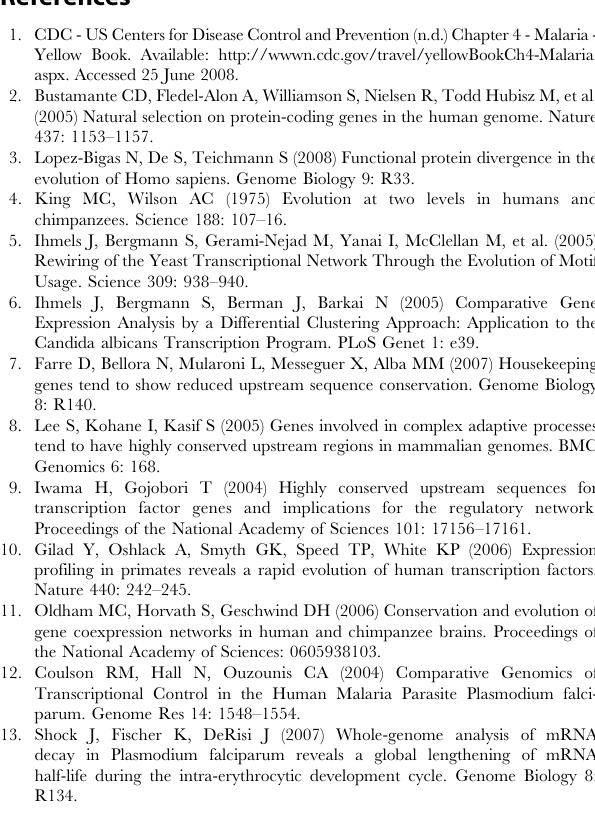
Table S7 Supplemental regulatory proteins identified based on domains. Proteins were identified by scanning the Plasmodium proteome with known regulatory domains from the Protein Families Database, PFAM. Table S8 Interspecies correlations for P. falciparum genes with orthologous expression data in both 3D7 and HP. Found at: doi:10.1371/journal.pone.0003122.s008 (0.13 MB XLS) Text S1 7-mer clusters used to create the 63 motifs. Each line in the file contains each of the clusters used to create the position weight matrices utilized in the paper. Note that 43 of the 63 clusters are